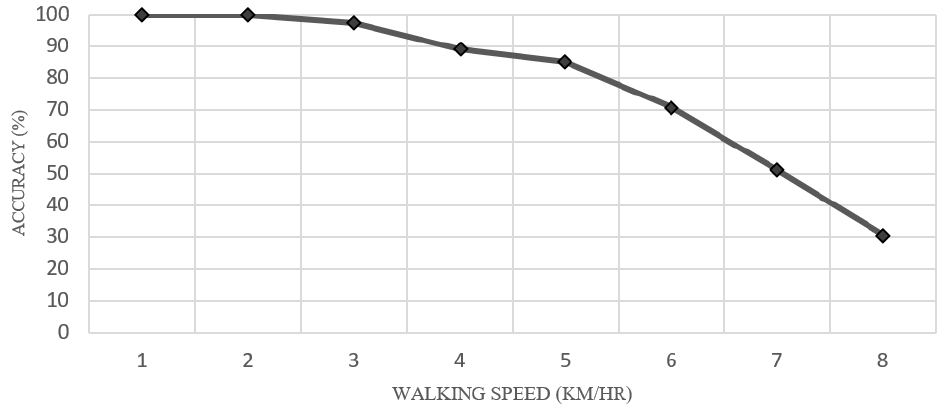
Figure 7. Walking speed affects the prediction accuracy of the kNN algorithm.